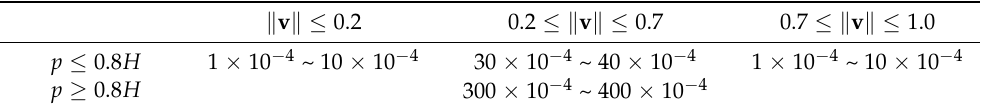
Table 17. Wear coefficient k w